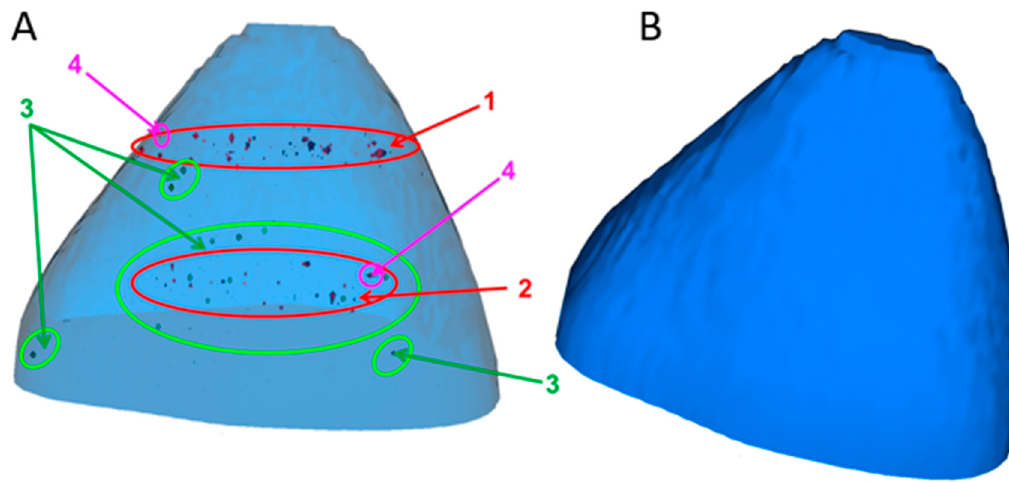
Figure 6. Time-of-flight secondary ion mass spectrometry (ToF-SIMS) ion reconstruction of the 3D depth profile (20 µm × 15 µm × 3.5 µm) of a single HuH-7 cell, which was co-exposed to CeO 2 NPs (100 µg mL − 1 ) and 5 mmol L-1 APAP for 24 h. CeO 2 NP aggregates are shown in red color (red circle), APAP-CeO(OH) particles are shown in green color (green circle). 1 and 2 (red) indicates the intracellular location of CeO 2 NPs agglomerates, 3 (green) indicates the intracellular localization of APAP-CeO(OH) particles, whilst 4 (pink) indicates the localization of mixed agglomerates of CeO 2 NPs and APAP-CeO(OH) particles. The cell membrane is being visualized in translucent ( A ) or solid ( B ) blue and reconstructed from the C 3 H 8 N+ signal that originates from phosphatidylcholine.